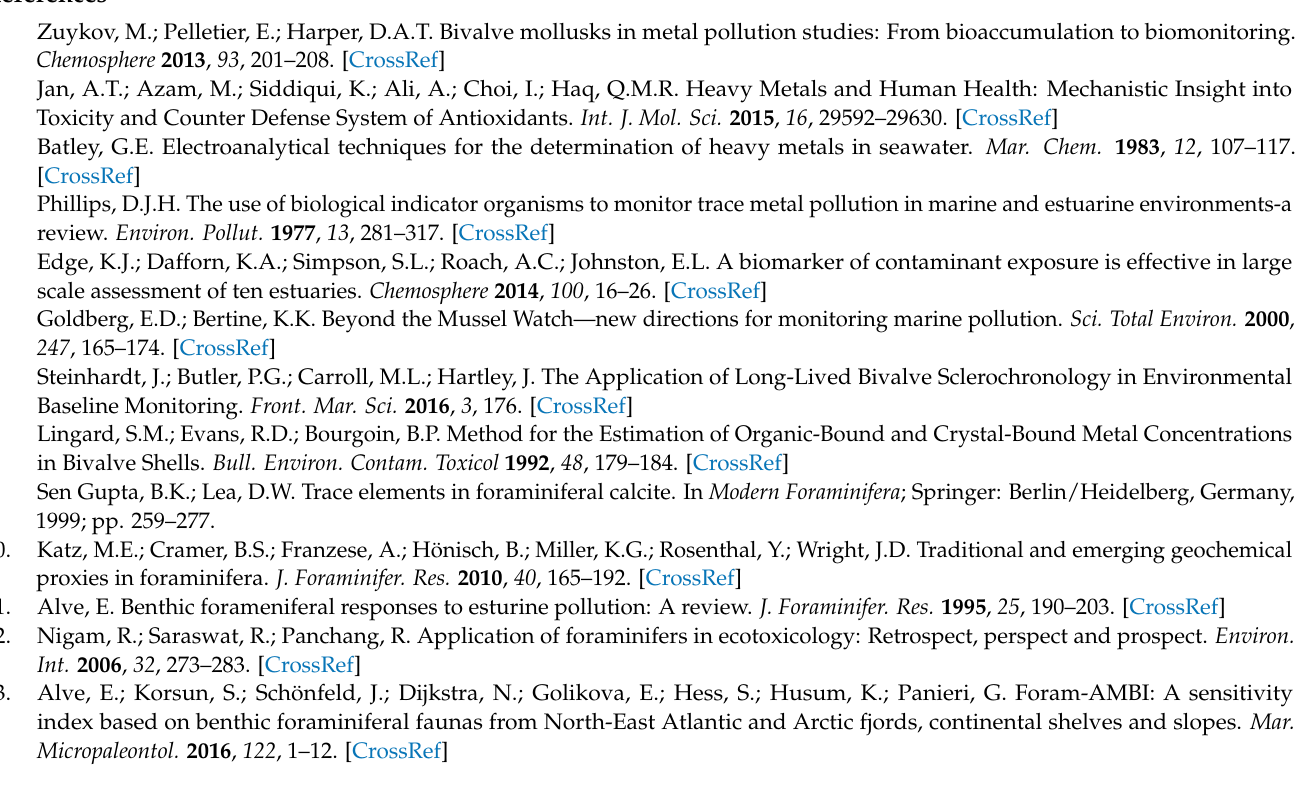
(defined as 3 SD of the procedural blank) for the studied metals; Table S3.1: Seawater dissolved concentrations collected in March 2021 in Nachsholim Site; Table S4.1: Comparing ICPMS and LA- ICPMS from July 2013; Table S4.2: Statistical comparison of metal/Ca between March and August 2021; Table S4.3: Statistical comparison of metal/Ca between single chamber 2013–2014 LA-ICPMS analyses to whole shell 2021 ICPMS records; Table S4.4: Comparing ICPMS and LA-ICPMS; Table S4.5: Statistical comparison of metal concentration between March and August 2021; Table S4.6: Statistical comparison of metal/Ca between single chamber 2013–2014 LA-ICPMS analyses to